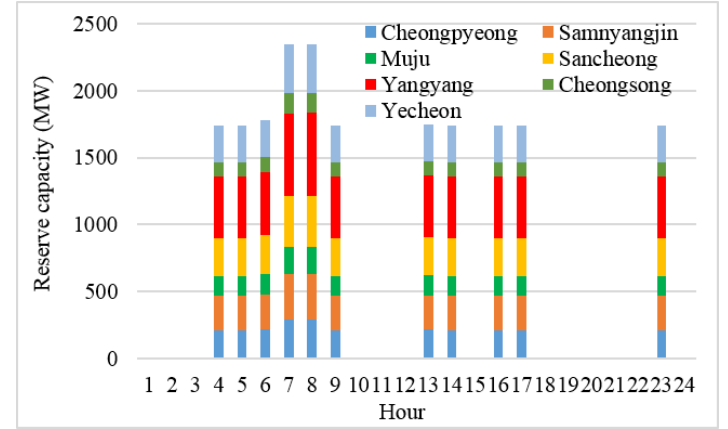
Figure 5. Hourly reserve capacity in 2016 based on the proposed method.